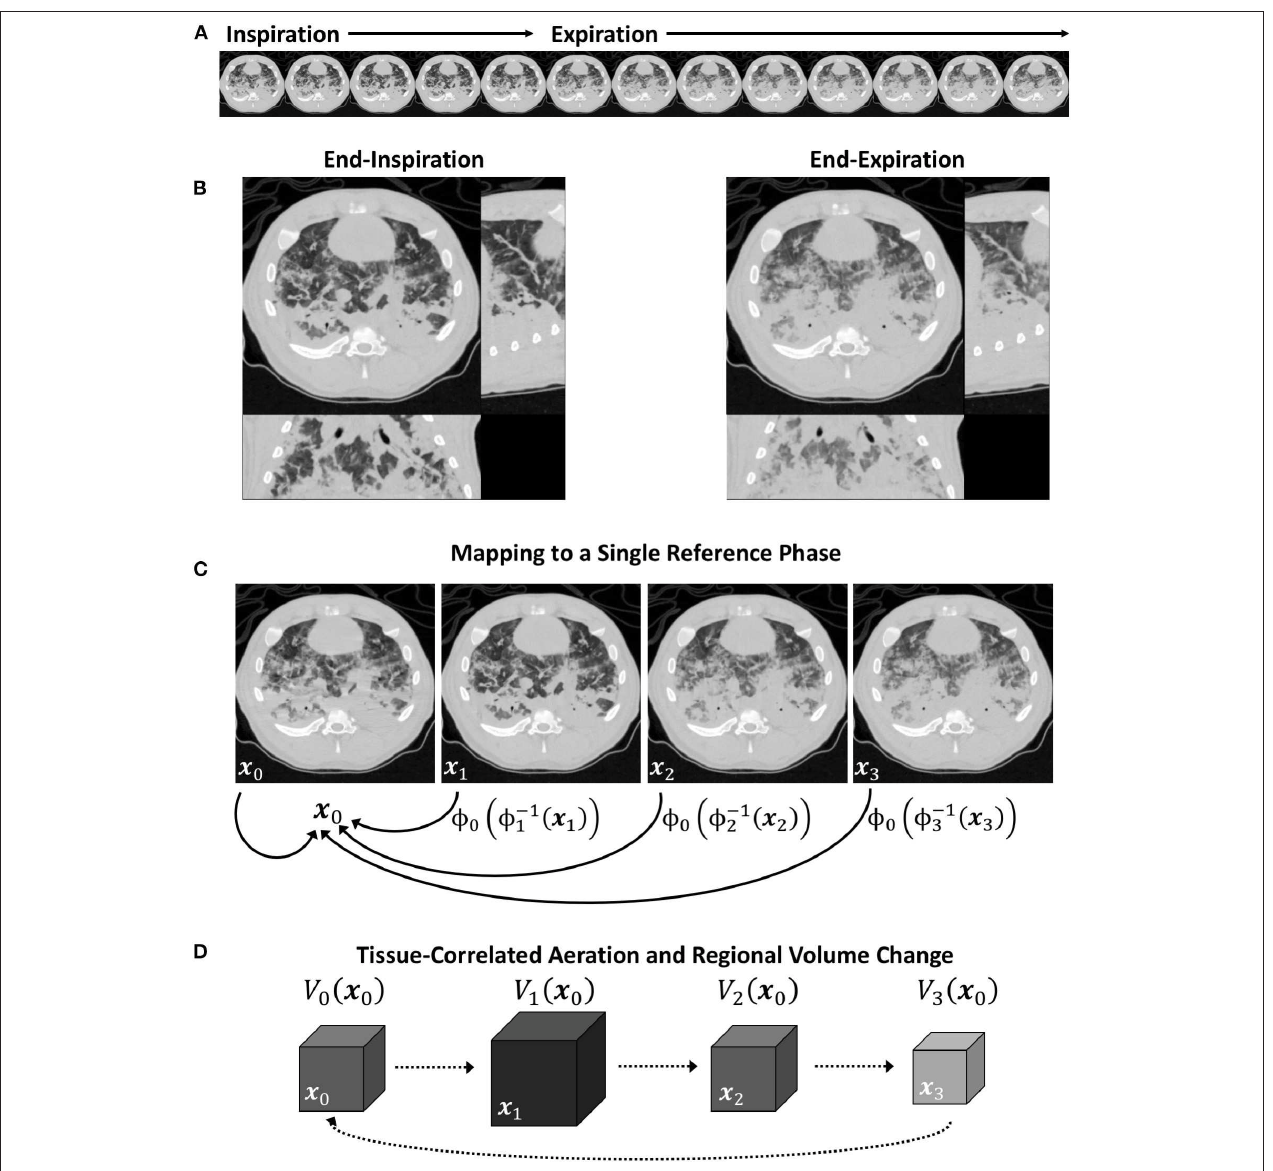
FIGURE 2 | Schematic of a periodic 4DCT image sequence during conventional mechanical ventilation (A) , with inspiratory and expiratory phases (B) . Image registration is used to map each image in the sequence to a single reference phase (C) , after which intratidal variations in aeration and regional volume may be associated to specific regions of lung tissue (D)